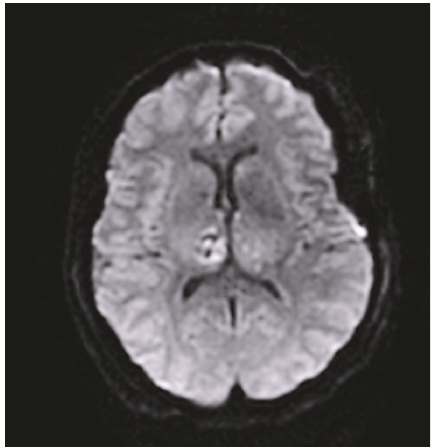
Figure 1: Diffusion weighted image MRI from postoperative day 1. Note . Increased signal intensity in right basal ganglia with punctate increases on the left indicating acute